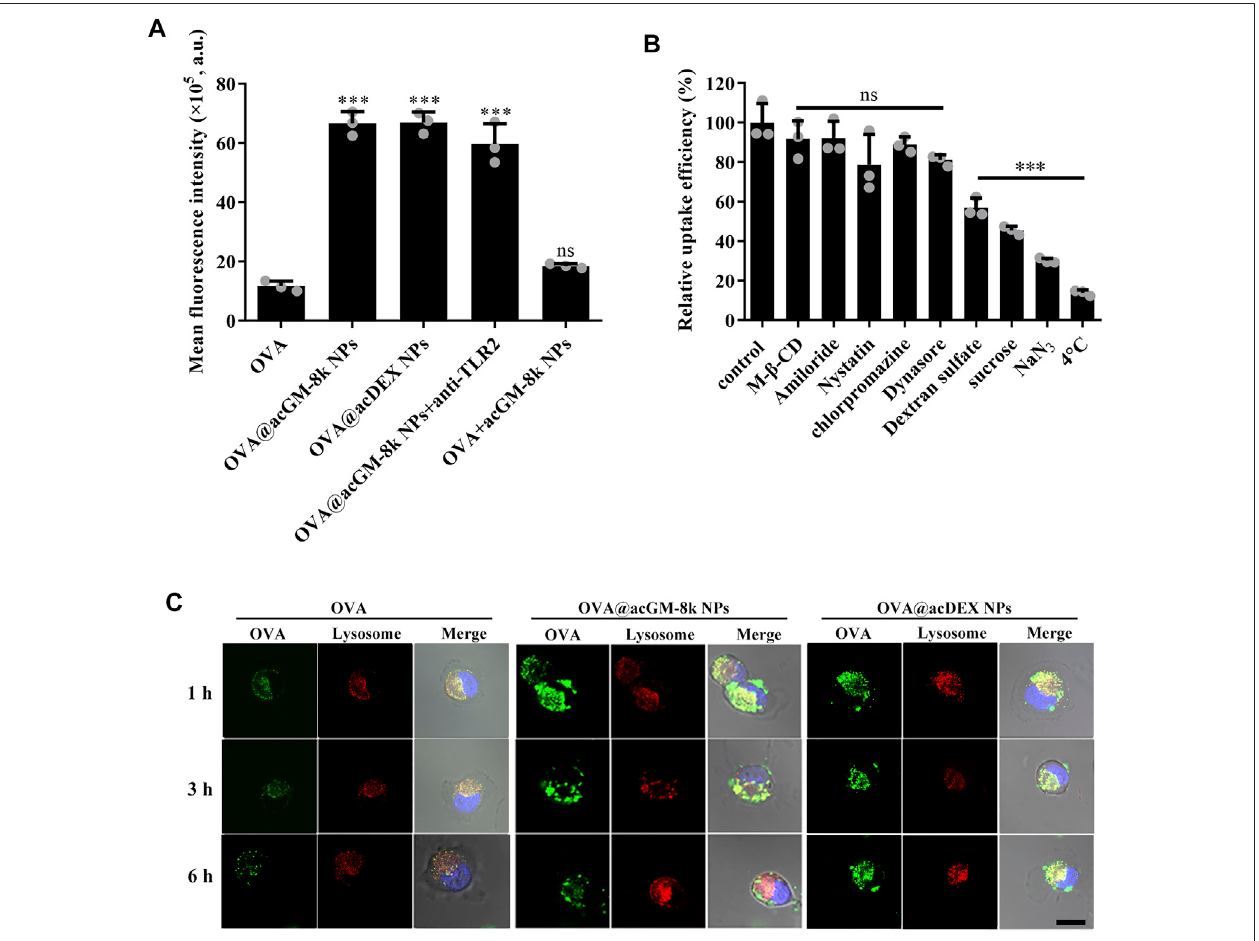
FIGURE5| acGM-8kNPsenhancedcellularuptakeofOVA. (A) Cellularuptakeef fi ciencyofOVA@acGM-8kNPs. (B) ScreeningofpotentialmechanismsofOVA@ acGM-8k NPs internalization by DC2.4 cells. (C) Confocal microscopy imaging of OVA@acGM-8k NPs in DC2.4 cells (scale bar: 10 μ m). Green: FITC-OVA; Red: lysotrackerred;Blue:DAPI.*** p < 0.001vsthecontrolgroup;ns:nosigni fi cance; n =3:datawereobtainedfromthreereplicatesofonerepresentativeexperimentoutof three. All numerical values are given as average values ± standard deviation. Statistical analysis was performed using Prism Software (GraphPad, United States), followed by one-way ANOVA analysis with Dunnett ’ s post hoc